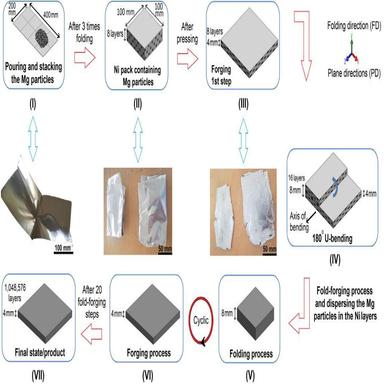
FE-SEM images showing the fragmentation of nickel foil layers within the magnesium matrix after AFF treatment and formation of Mg/Ni multilayers composite structure for samples with (a, b) low and (c, d) high contents of Mg at (a, c) low and (b, d) high magnifications.